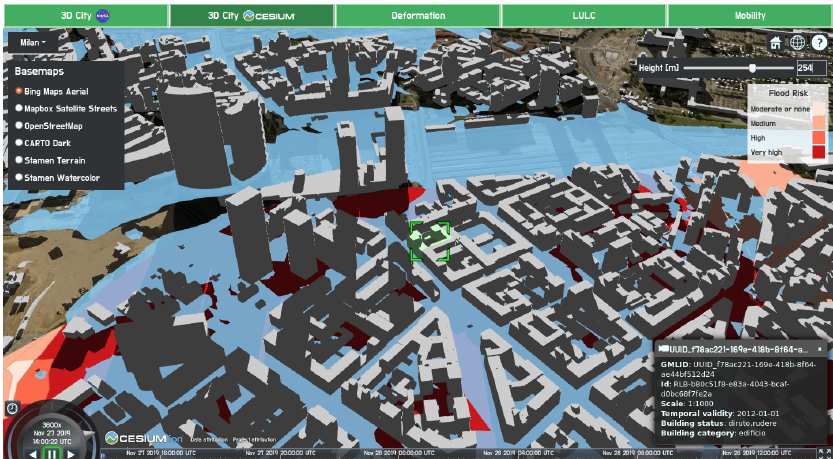
Figure 5. Flood simulation in Milan with flood risk map and the visualization of CityGML data on a virtual globe created using